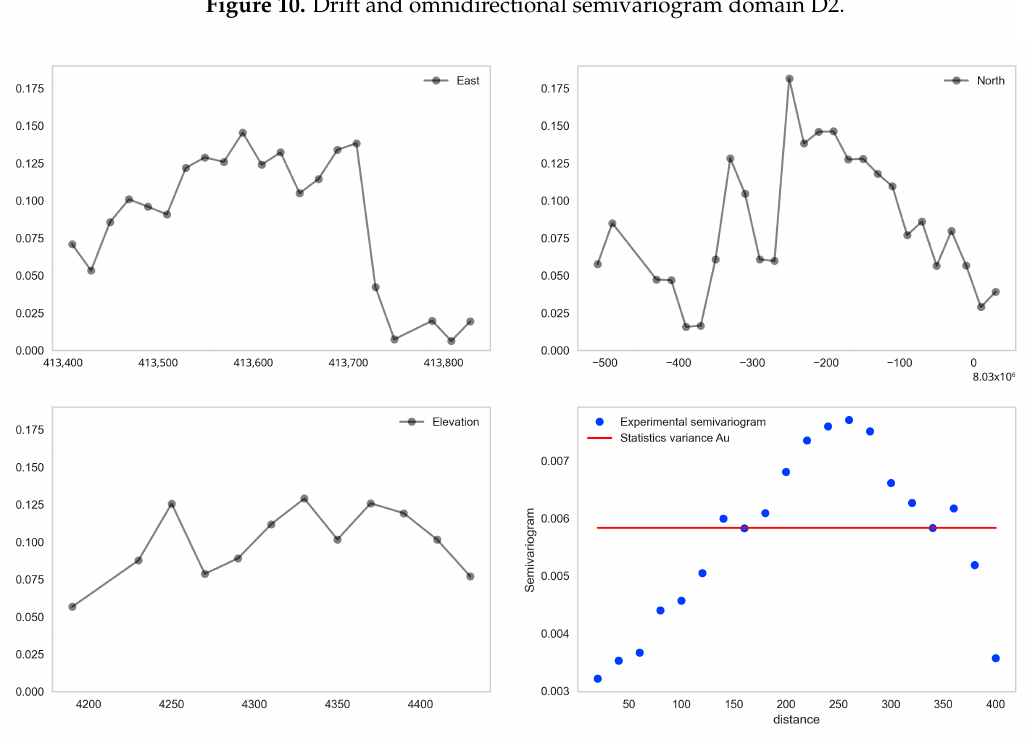
Figure 10. Drift and omnidirectional semivariogram domain D2.